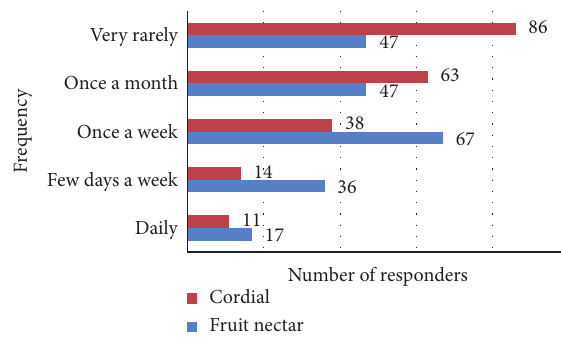
Figure 2: Frequency of consumption of